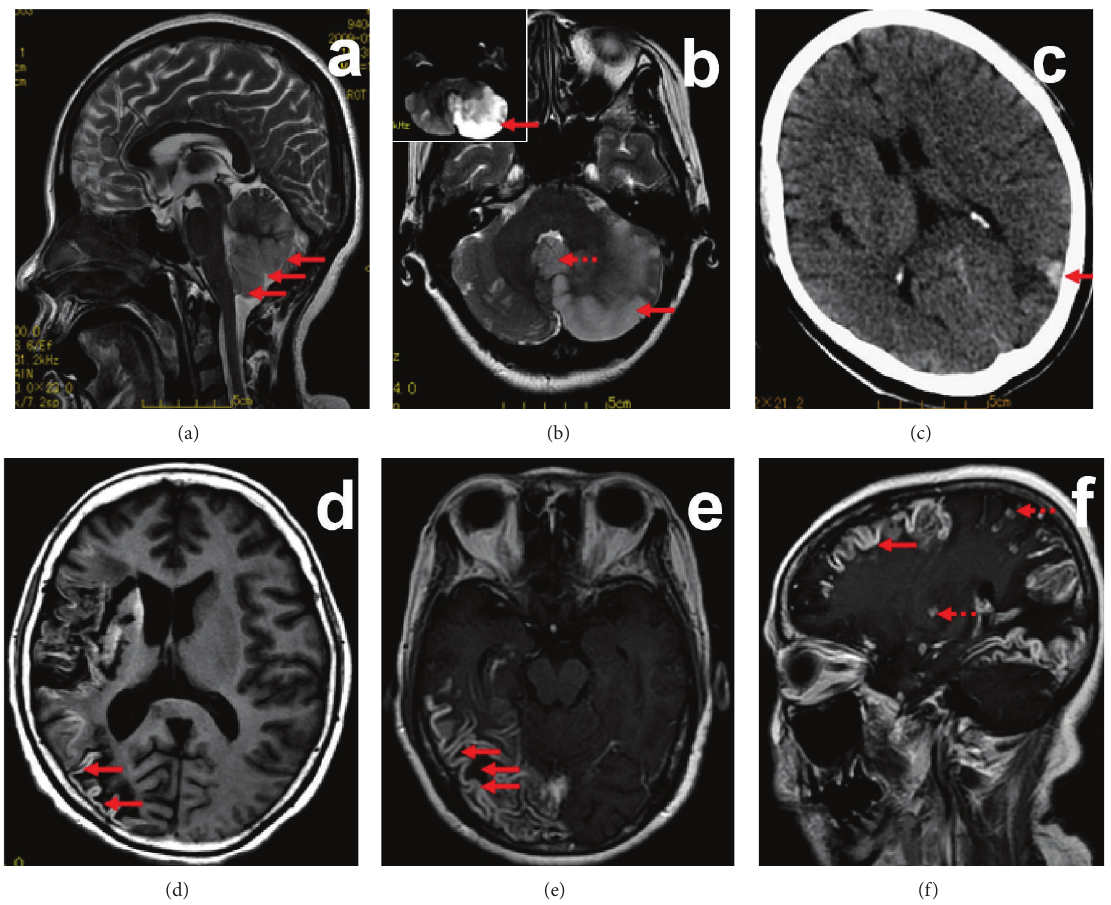
Figure 3: Unusual imaging findings in patients with myxoma with embolism. (a) A patient’s death was due to the mass effect of a large infarction associated with compression. (b) Crosssection of MRI revealed a new infarction of his left cerebellum (arrow). Part of the infarction compressed the fourth ventricle (dotted arrow). (c) CT showed a haematoma of the left cornu posterius ventriculi in the same patient (arrow). ((d)–(f)) MRI revealed a linear hyperintense band along the gyral margins (arrow) on T1-weighted imaging, which was defined as cortical laminar